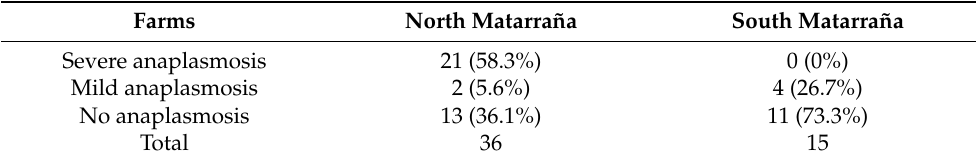
Table 4. Analysed farms with severe anaplasmosis clinical signs in the Matarraña region. Farms North Matarraña